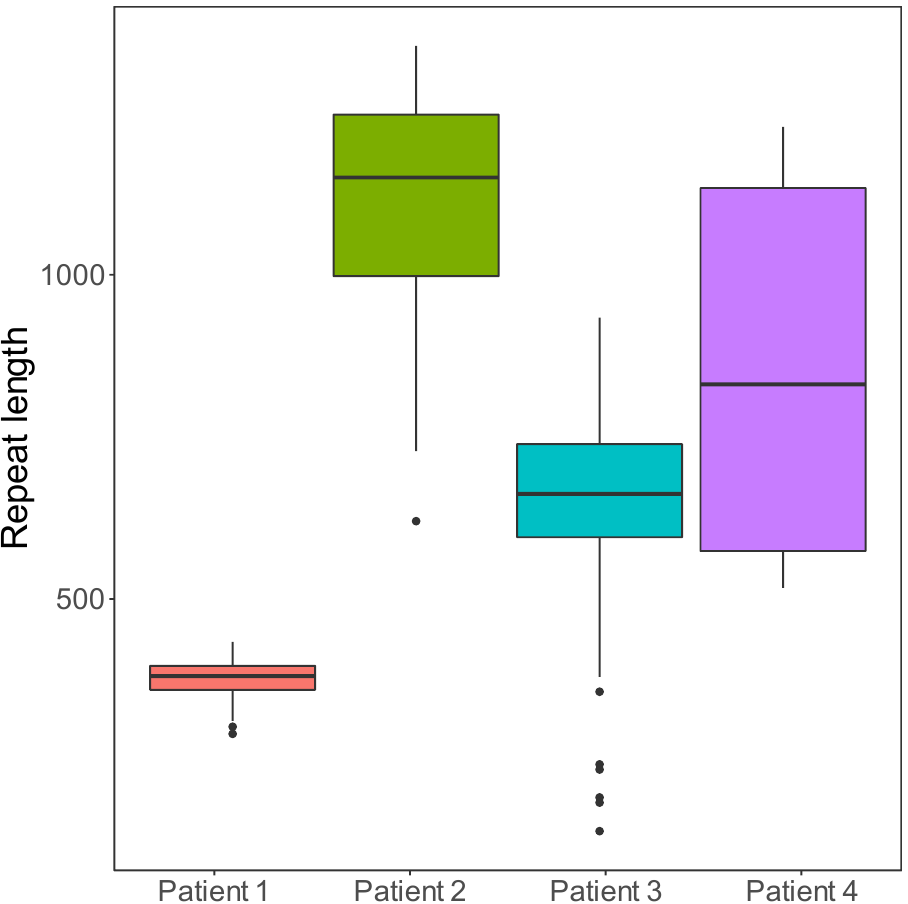
Figure 1. Repeat lengths of the somatically unstable expanded allele for all four patients. The boxplots indicate medians and quartiles of disease allele lengths, and the dots represent outliers. Table 2. Age and repeat characteristics of the expanded allele.